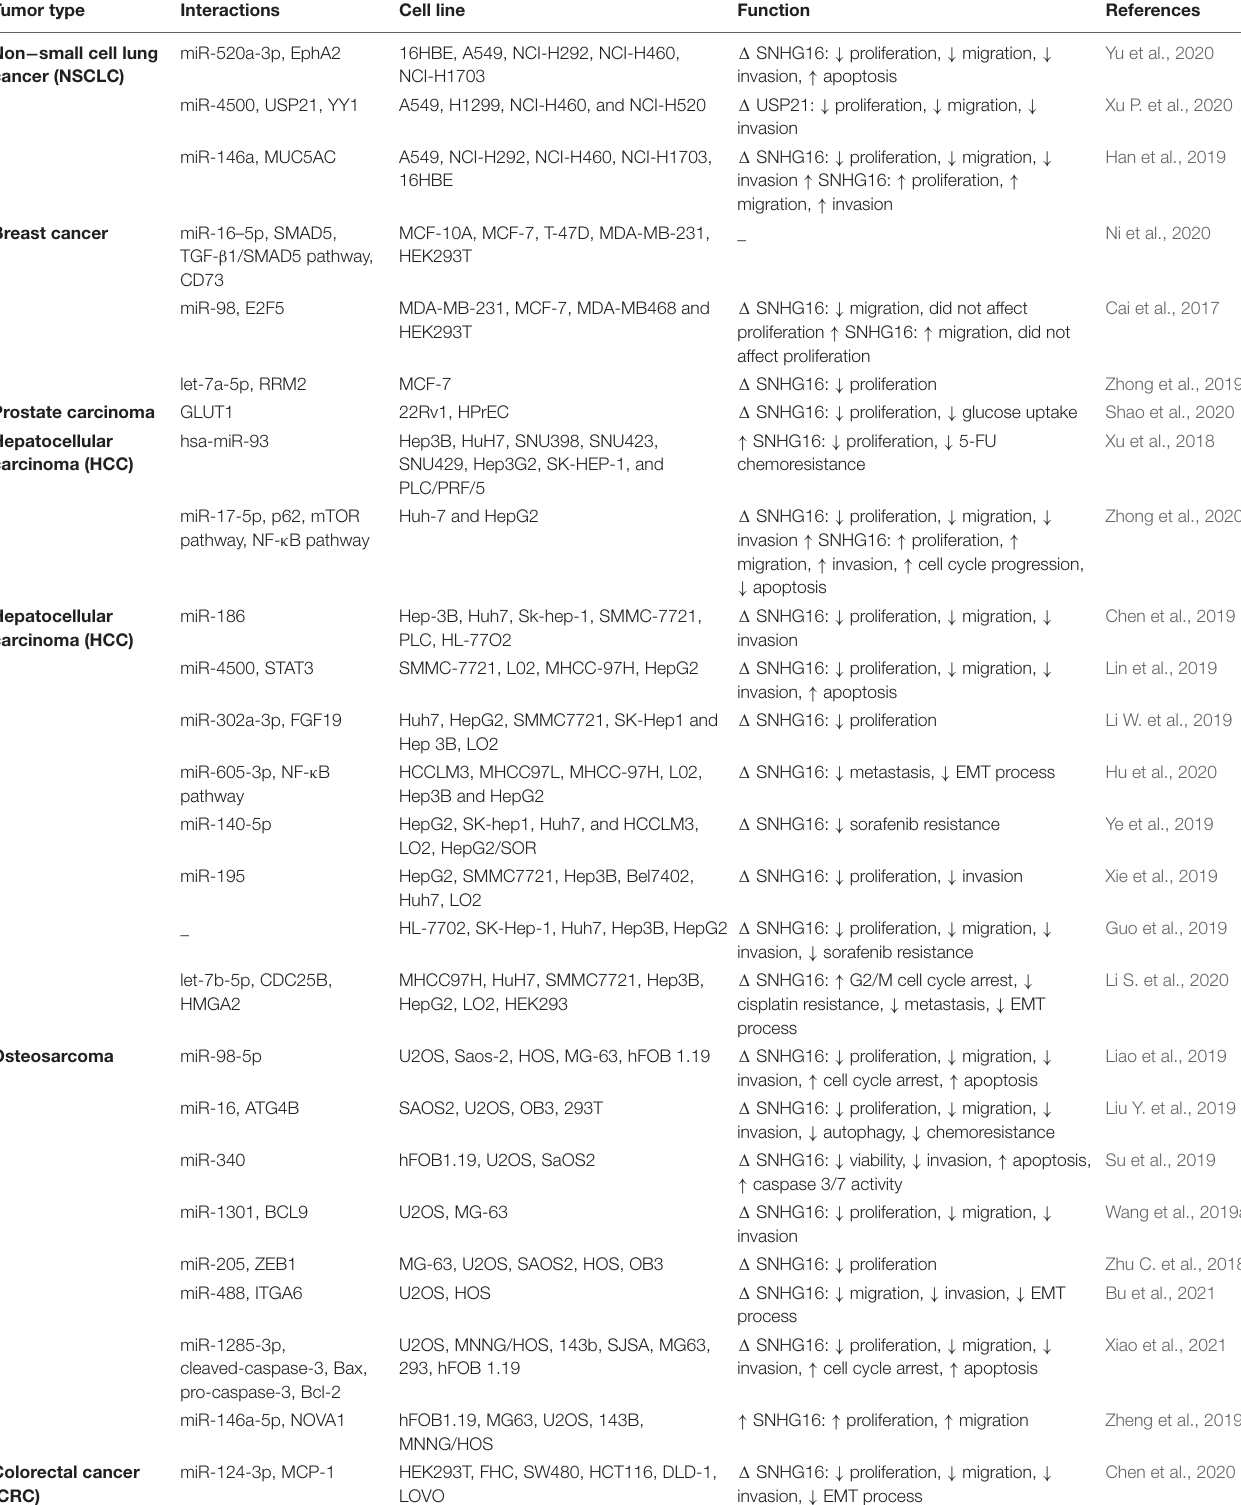
TABLE 1 | Outline of researches which measured expression of SNHG16 in cell lines ( (cid:49) , knock-down or deletion; 5-FU, 5-fluorouracil; VM, vasculogenic mimicry). Tumor type Interactions Cell line